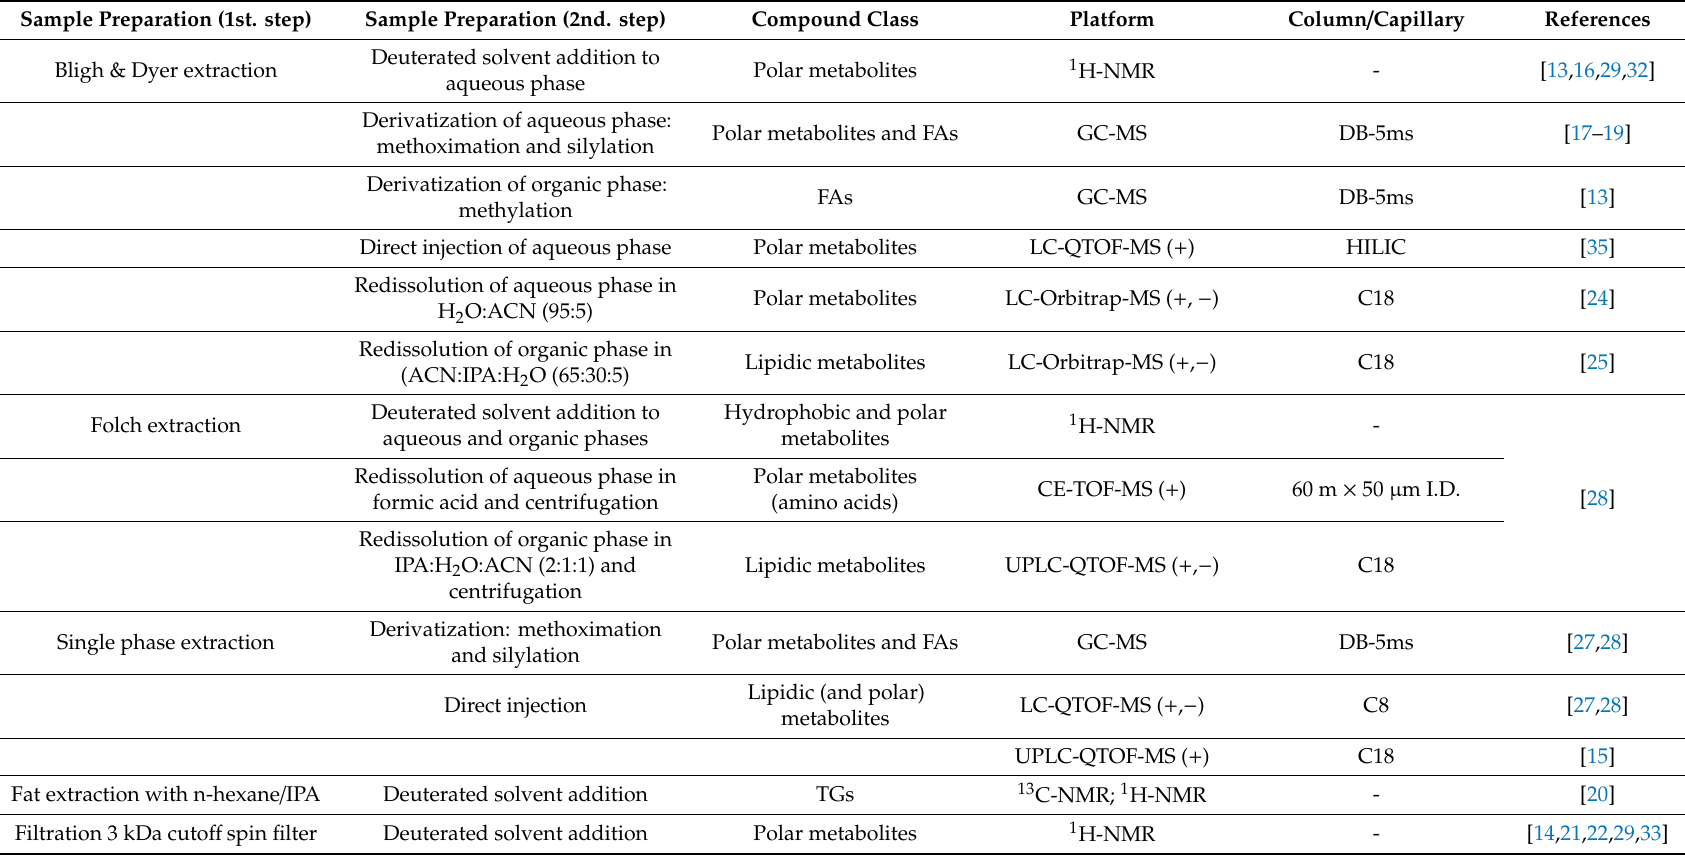
Table 1. Sample preparation steps and platforms employed in untargeted analysis of HM